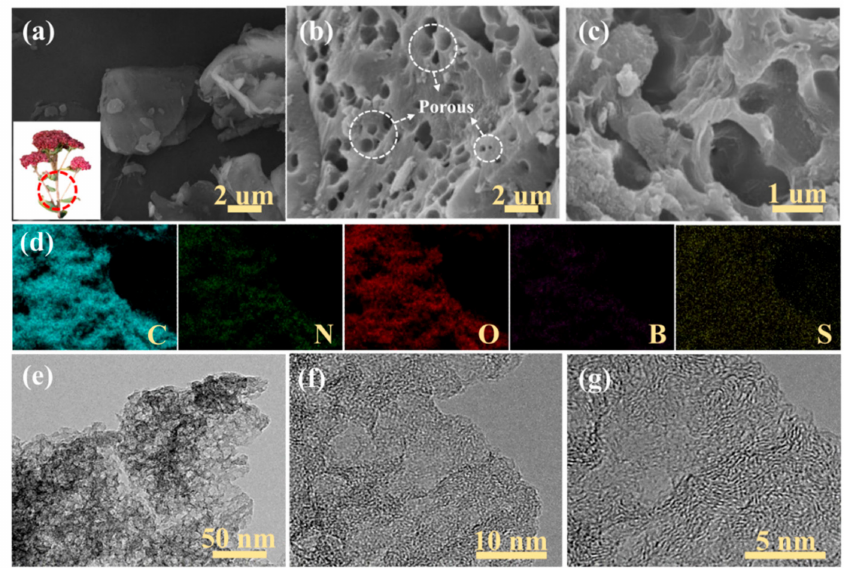
Figure 2. ( a ) SEM images and a photograph (inset) of SC; ( b , c ) SEM images of SC; ( d ) element mapping of C, N, O, B, and S in B/S-SC S -1; ( e – g ) TEM images of B/S-SC S -1 at different